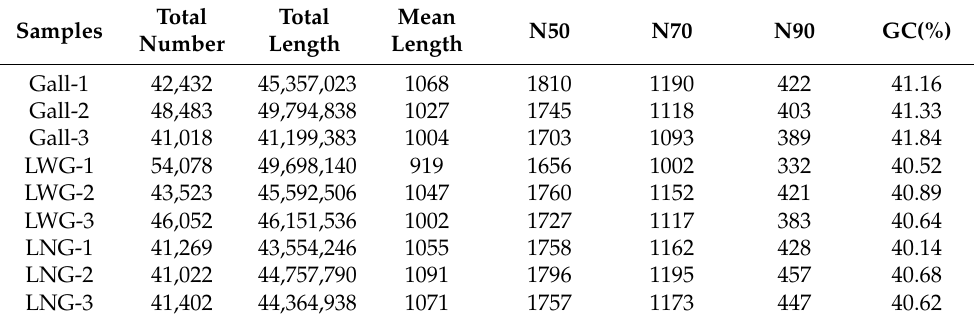
Table A4. Quality evaluation of